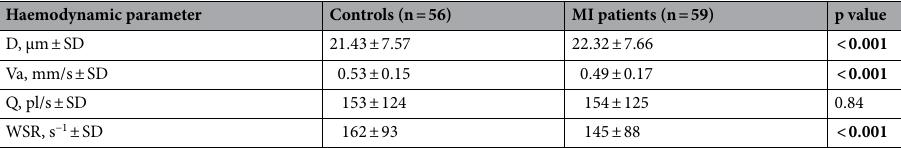
Table 4. Summary of conjunctival microcirculatory parameters for all vessel sizes for both populations. Bold values are statistically significant (p < 0.05). D diameter, SD standard deviation, Va axial velocity, Q blood volume flow, WSR wall shear rate, MI myocardial